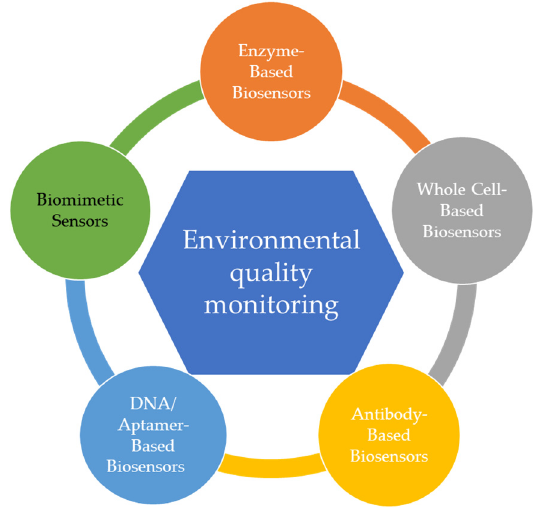
Figure 3. Biosensors used for the environmental quality monitoring.